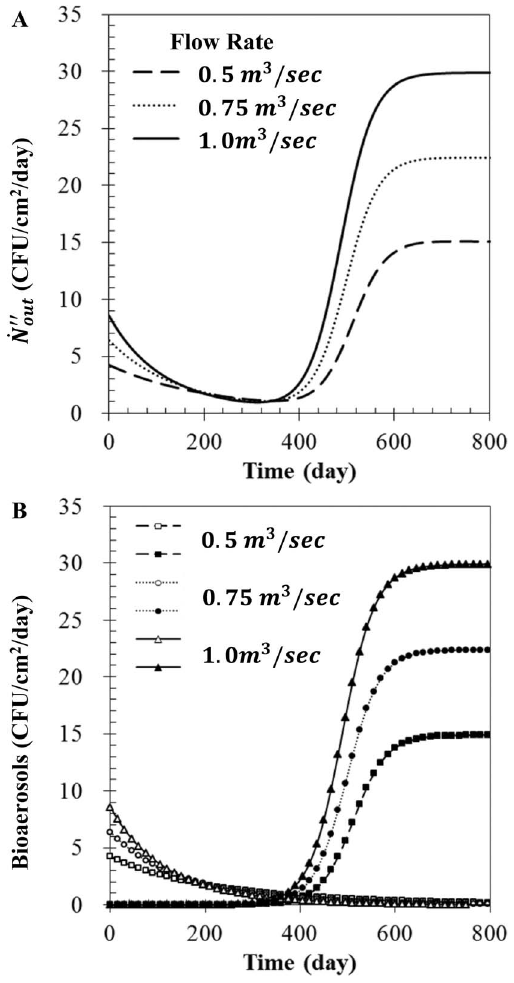
Figure 6. Bioaerosol number flux with various flow rates. (A) _ NN 00 , (B) _ NN 00 (open symbol), and _ NN 00 out penet when g anti =0.5, w nutrient =0, and C in =100 m g/m 3 .